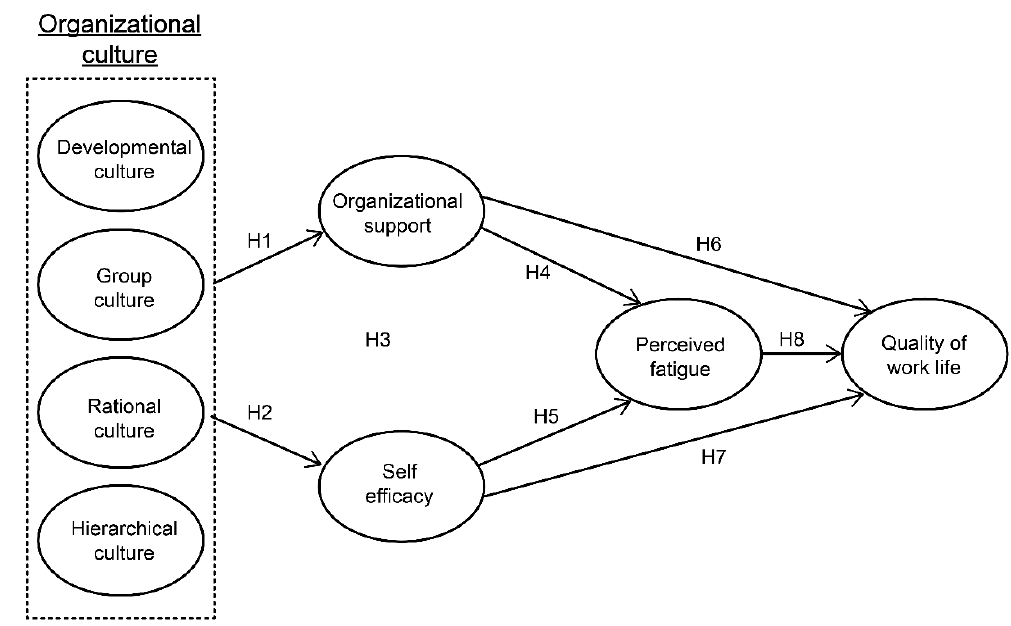
Figure 1. A conceptual framework based on Peterson and Wilson’s Culture-Work-Health model